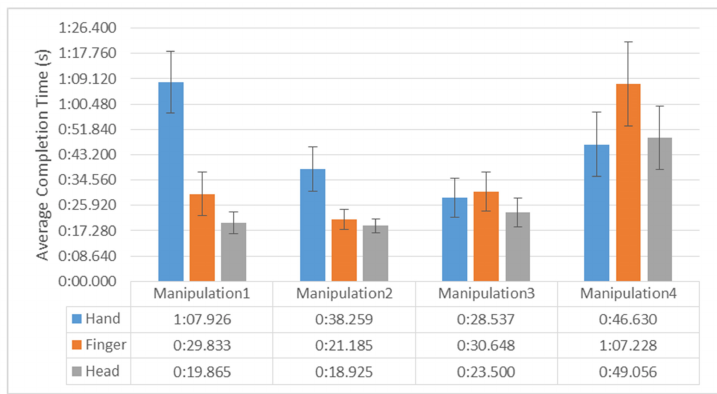
Figure 6. Mean completion time for each interaction ( +/ - standard deviation of the